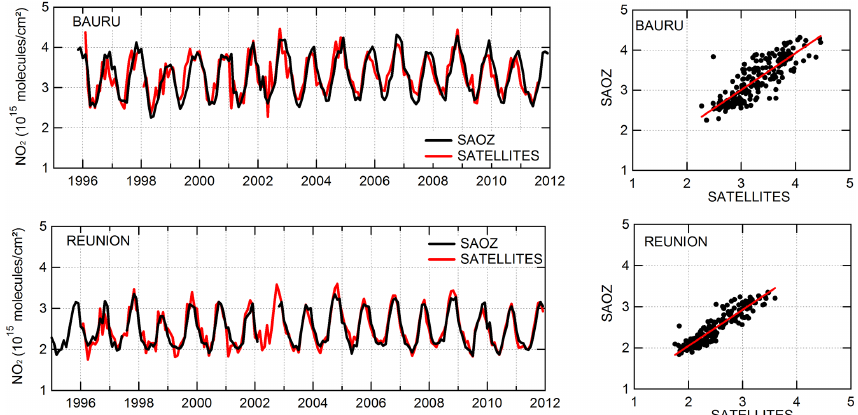
Figure 16. Left: SAOZ (black) and merged satellite (red) NO 2 columns (10 15 moleculescm − 2 ) in Bauru (top) and Reunion (bottom). Right: Correlation between SAOZ and merged satellite data ( r 2 = 0.89 in Bauru and r 2 = 0.92 in Reunion).